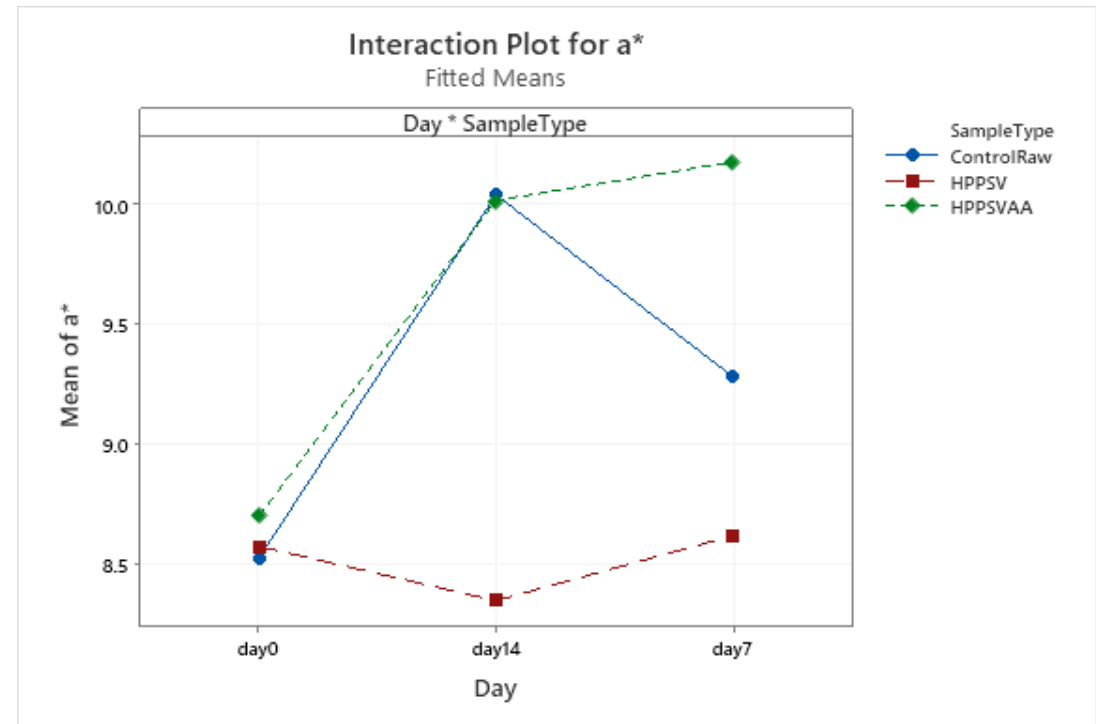
Figure A16 . Effect of treatments and storage time on the L* coordinate of plant-based patty (HPPSV: HPP-SVCOOK).